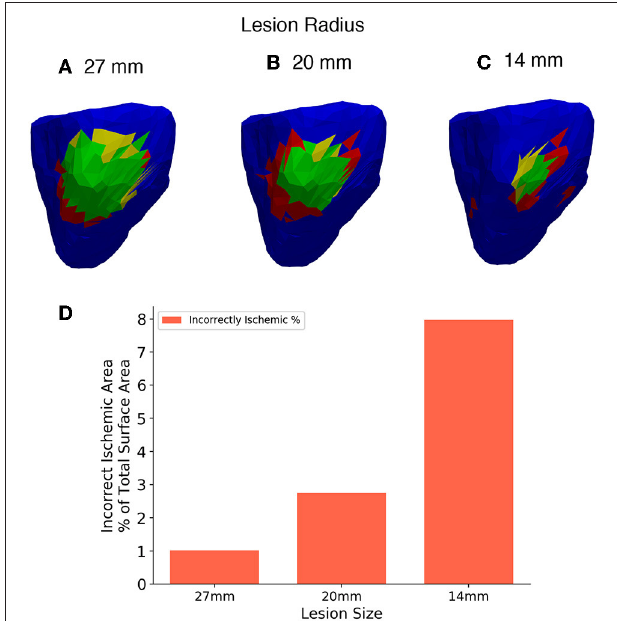
FIGURE 12 | (A–C) Three different lesion sizes reconstructed with the 2nd order Tikhonov solution and 512 leads. (D) Bar chart showing the areas incorrectly identified as ischemic in each solution as a percentage of the 27mm lesion area for comparison. Right lateral wall view and lesions have radius (A) 27mm, (B) 20mm, (C)